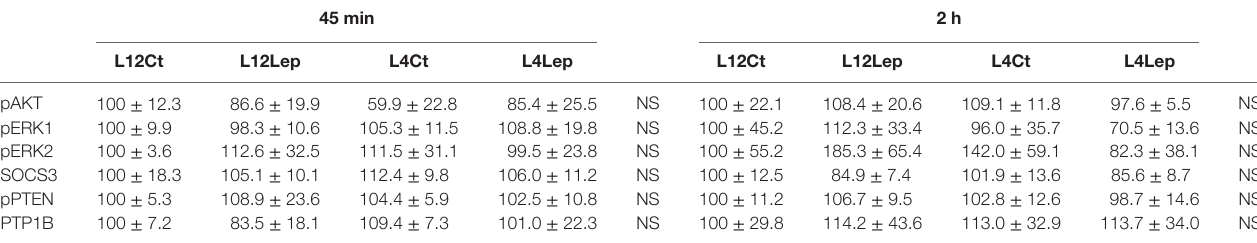
TaBle 3 | Relative protein levels of intracellular signaling molecules in the hypothalamus of male peripubertal rats from litters of 12 (L12) or litters of 4 (L4) pups that were treated with vehicle (control, CT) or leptin (Lep) and sacrificed 45 min or 2 h